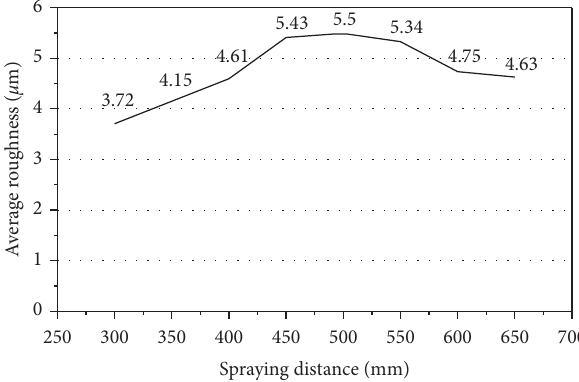
Figure 13: Average roughness curve with different spraying